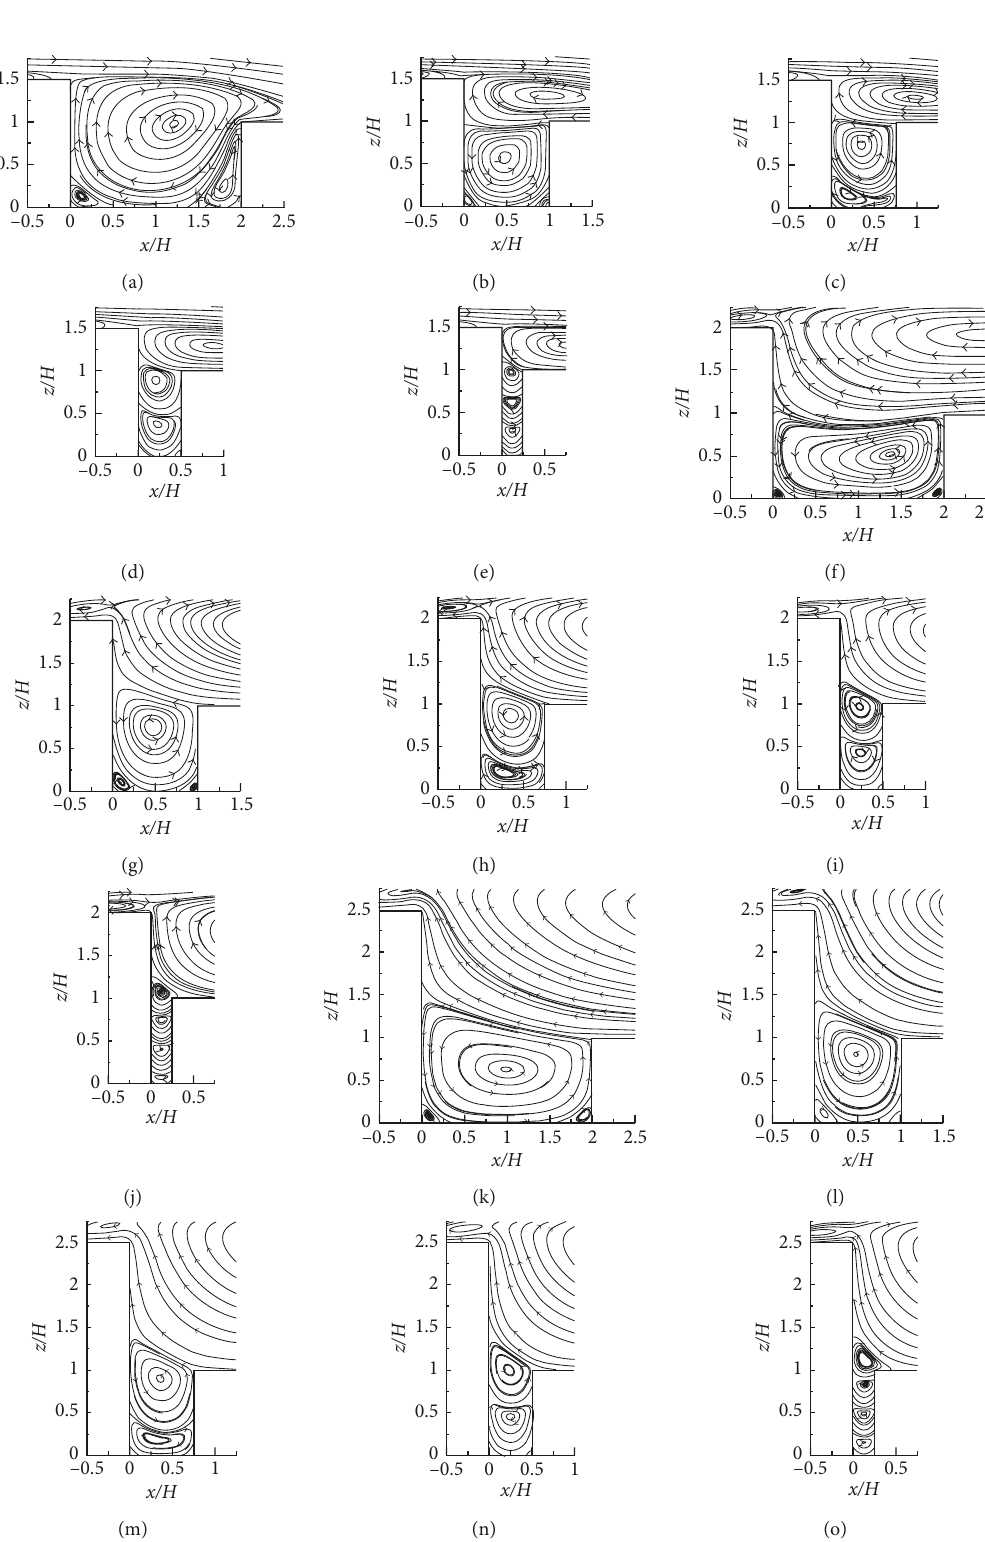
0.5 with H 2 / H 1 0.67 (a), H 2 / H 1 (cid:31) (cid:31) 0.4 (l); for AR 1.33 with H 2 / H 1 0.67 (c), H 2 / H 1 (cid:31) (cid:31) (cid:31) 0.4 (n); for AR 4 with H 2 / H 1 0.67 (e), H 2 / H 1 (cid:31) (cid:31) (cid:31)